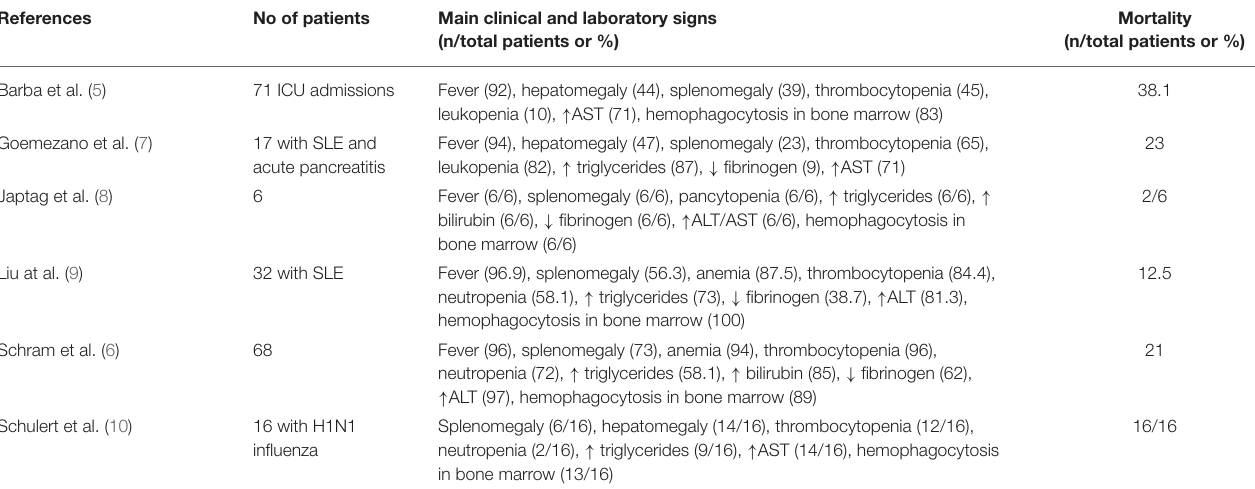
TABLE 1 | Synopsis of observational case-series of adult patients with macrophage activation published the last 5